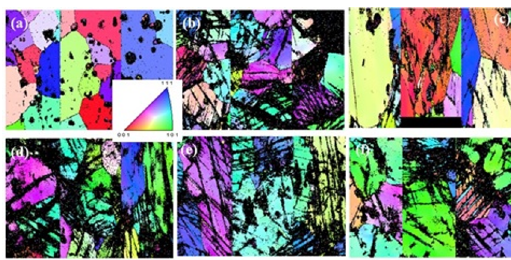
Figure 1. EBSD results, at room temperature, presented as maps of crystallographic orientations in reverse pole figures. (a) EQS, (b)